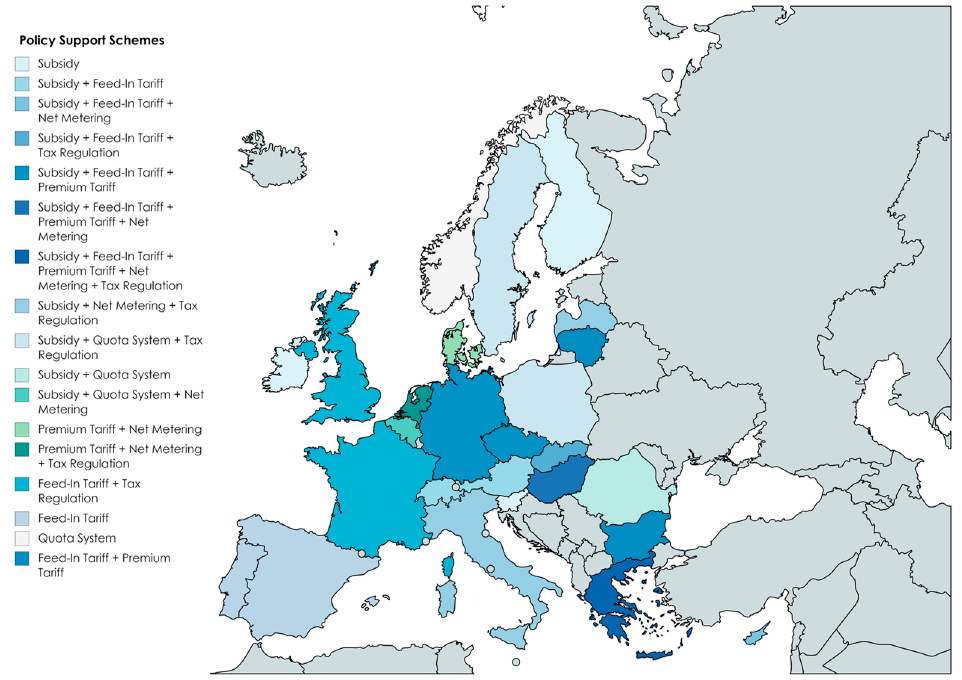
Figure 1. Solar PV support schemes in different European countries (own illustration).